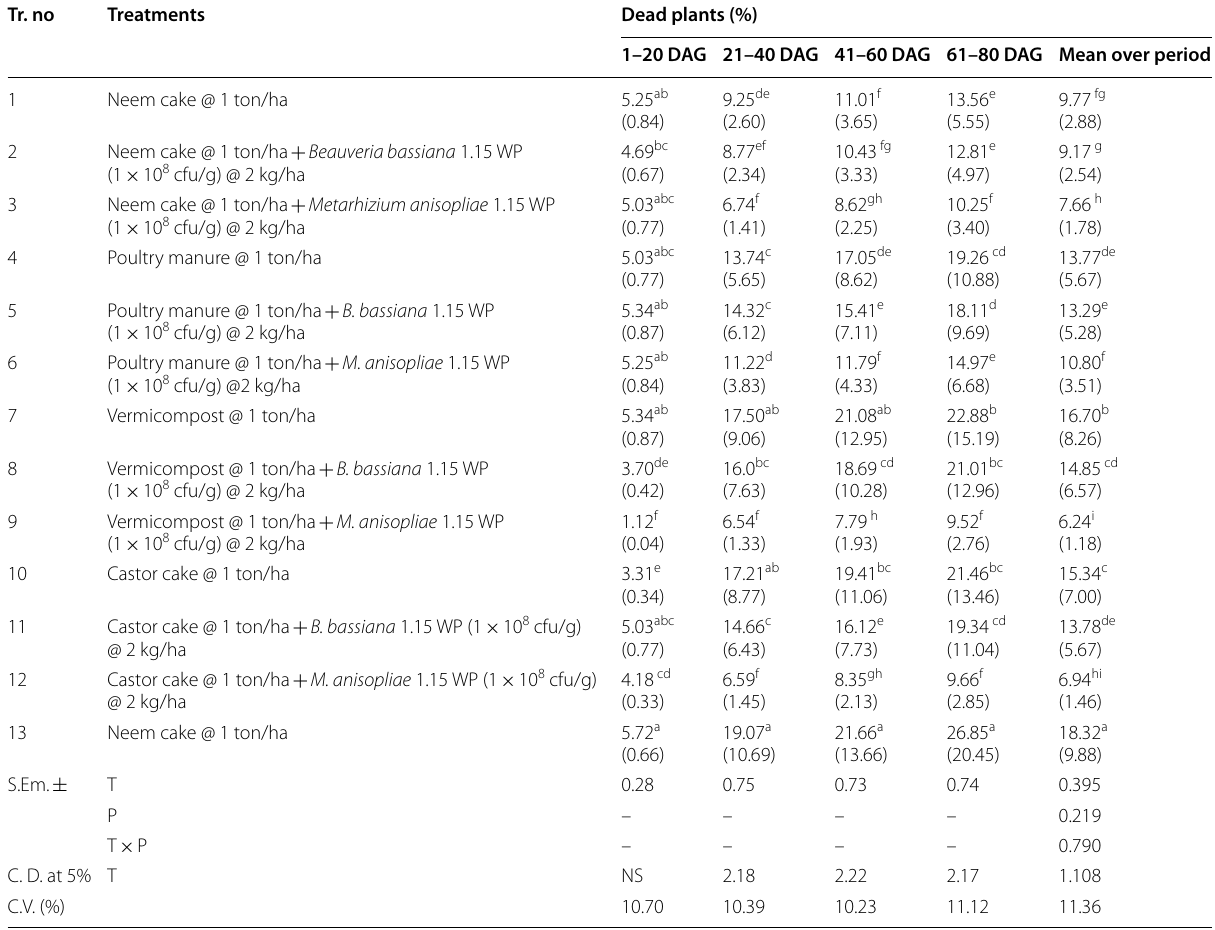
1. Figures in parentheses are retransformed values of arc sin transformation; DAG: Days after germination; 2. Treatment means with the letter(s) in common are not significant by DNMRT at 5% level of significance; 3. Significant parameters and their interactions: T, P, T